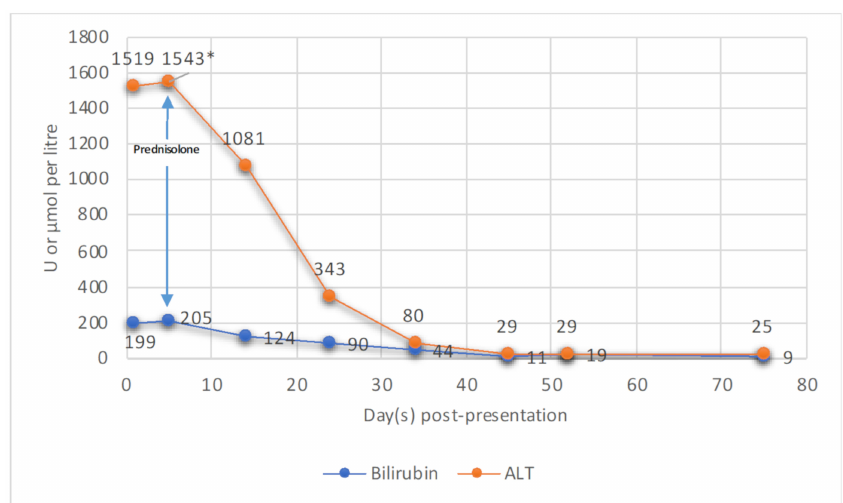
Figure 2. Graphical representation of bilirubin ( µ mol / L) and alanine transferase (ALT [U / L]) trends over a 75-day follow-up period from time of presentation. Prednisolone was commenced on Day 5 post-presentation